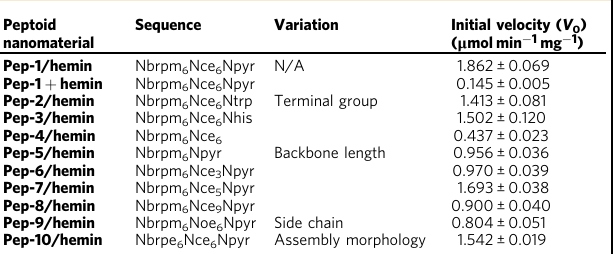
Table 2 Peptoids used for constructing peptoid/hemin peroxidase mimetics with mutations in sequence and the corresponding initial